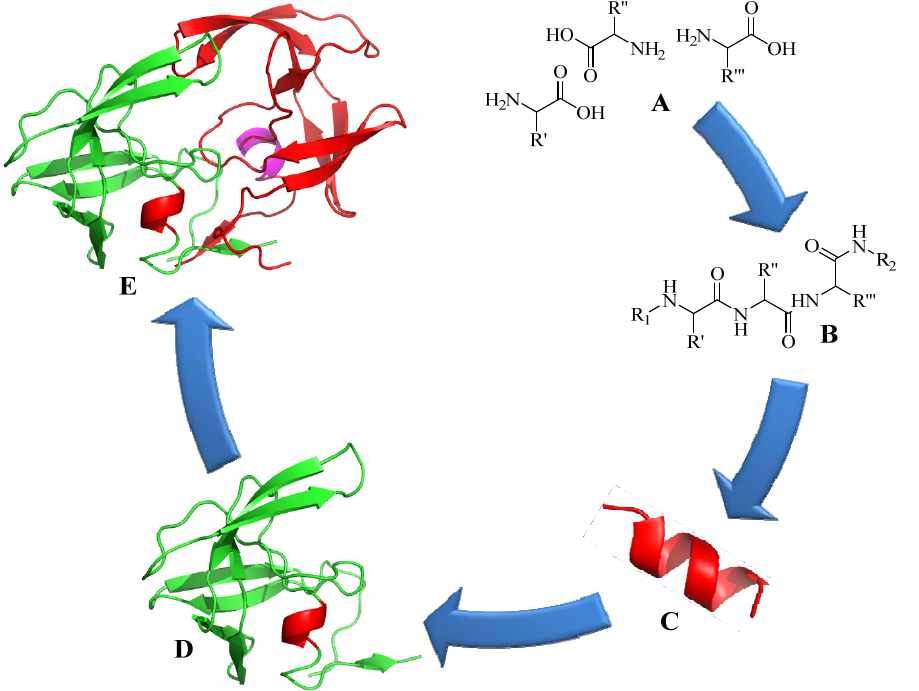
Figure 1. From amino acids to protein. ( A ) free amino acids; ( B ) primary structure (peptide bonds); ( C ) secondary structure ( α -helix or β -sheet); ( D ) tertiary structure (whole protein or subdomain protein); ( E ) quaternary structure (multiple domain protein, HIV Protease, Protein Data Bank (PDB) number = 1HSG)